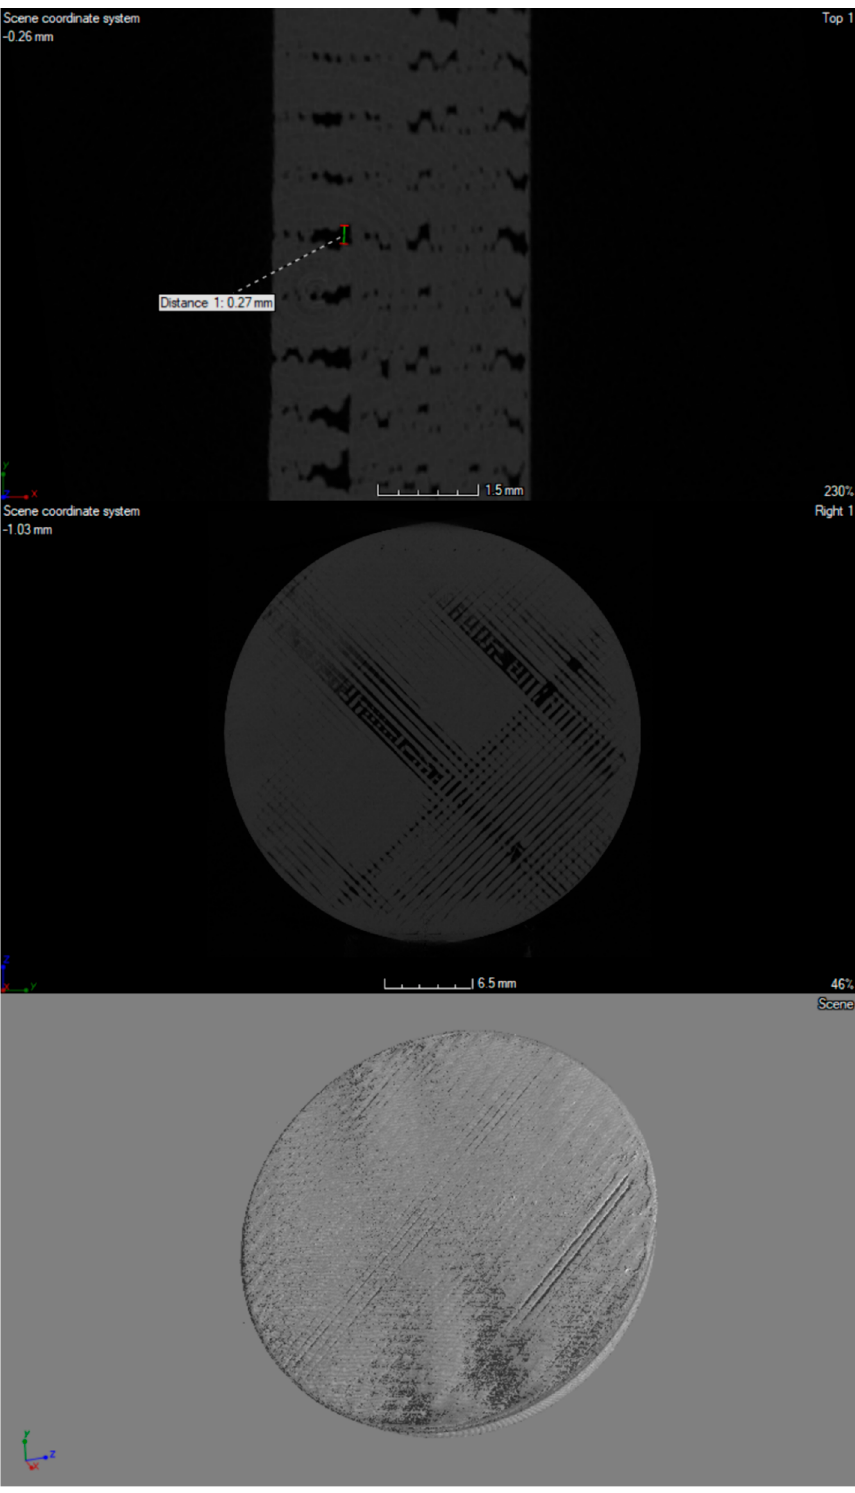
Figure 3. Micro CT imaging of 3D-printed porous standard plate modified with nanosilver .